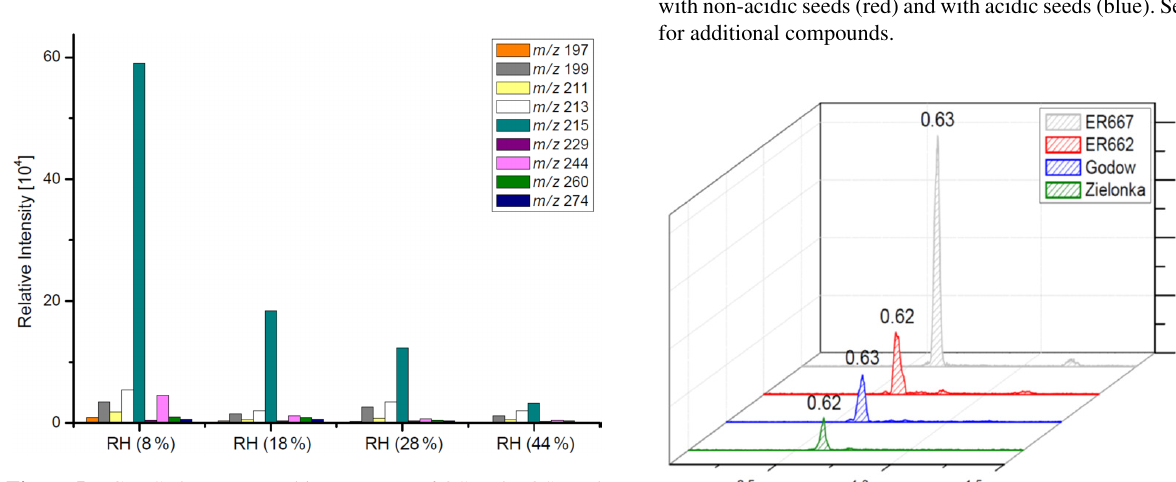
Figure 5. LC-MS chromatographic responses of OS and NOS prod- ucts from the acidic-seed experiments.